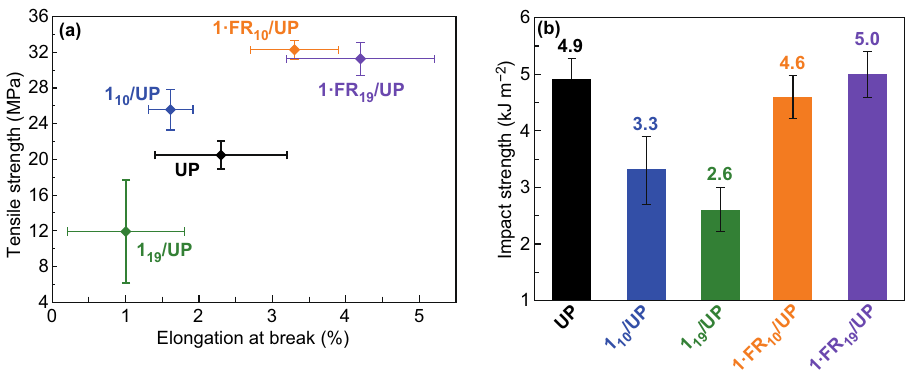
Fig. 21 a Tensile properties and b impact strengths of UP and composites. Reproduced from Ref. [45] with permission from American Chemi‑ cal Society, https ://pubs.acs.org/doi/10.1021/acsam i.9b023 57. Further permission related to the material excerpted should be directed to the